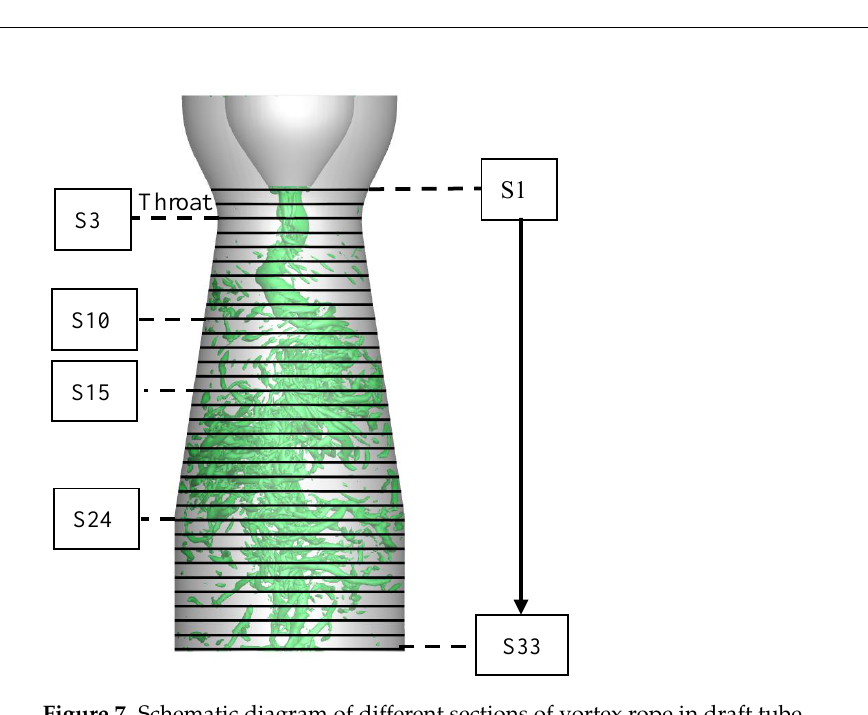
Figure 8. Schematic diagram of image processing process on a 2D section of draft tube. ( a ) Original image; ( b ) binarization processing; ( c ) morphological operation (open operation and closed opera- tion); ( d ) mark vortex.